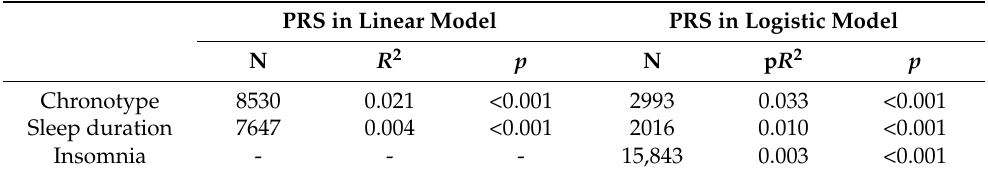
Table 1. Summary of the regression models for chronotype, sleep duration and insomnia based on FINRISK participants. Dependent and independent variables are sleep traits and PRS, respectively. PRS = polygenic risk score, pR 2 = pseudo-R 2 .